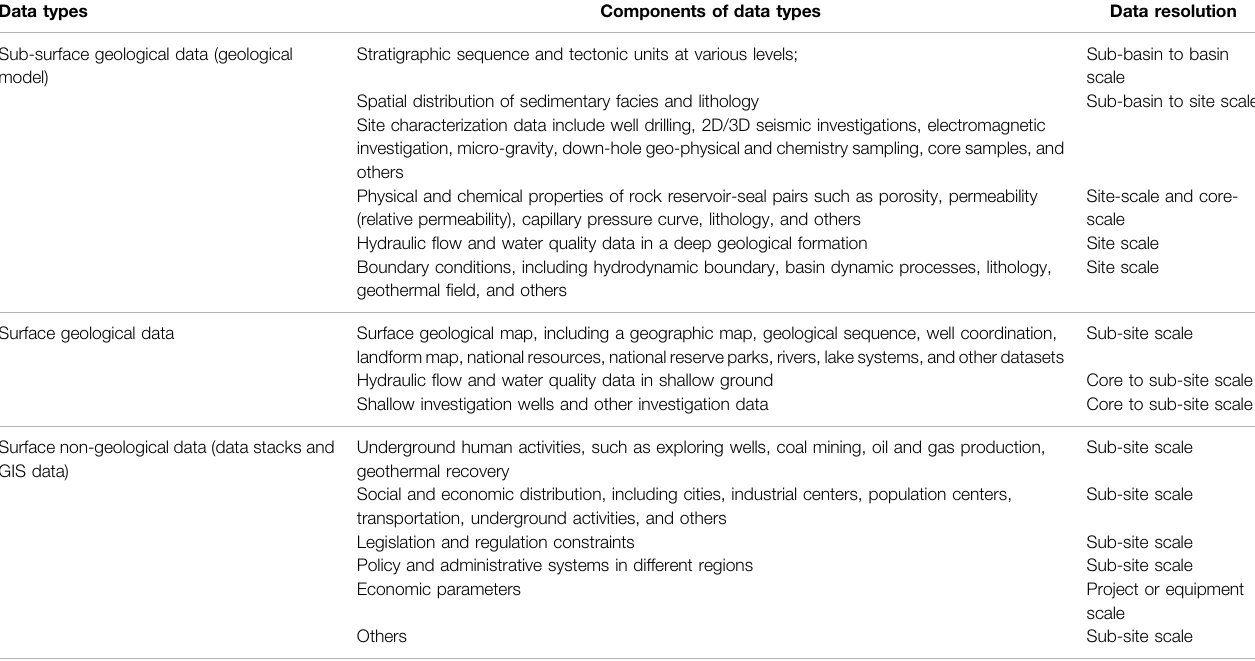
TABLE 1 | Various data types and spatial scales for storage capacity